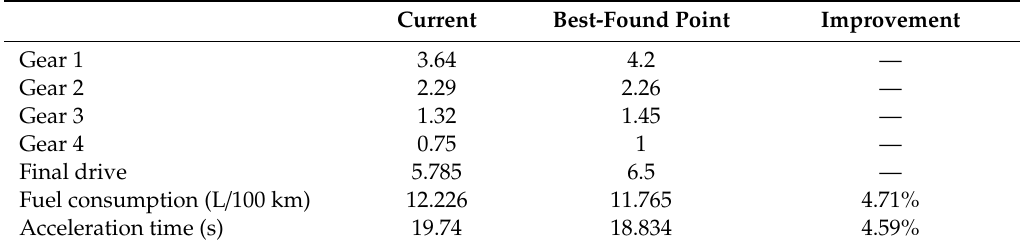
Figure 14. Optimal speed ratios and optimal objectives with respect to the weight factor. ( a ) Optimal speed ratios; ( b ) Optimal objectives. Table 4. A comparison of the optimization results.